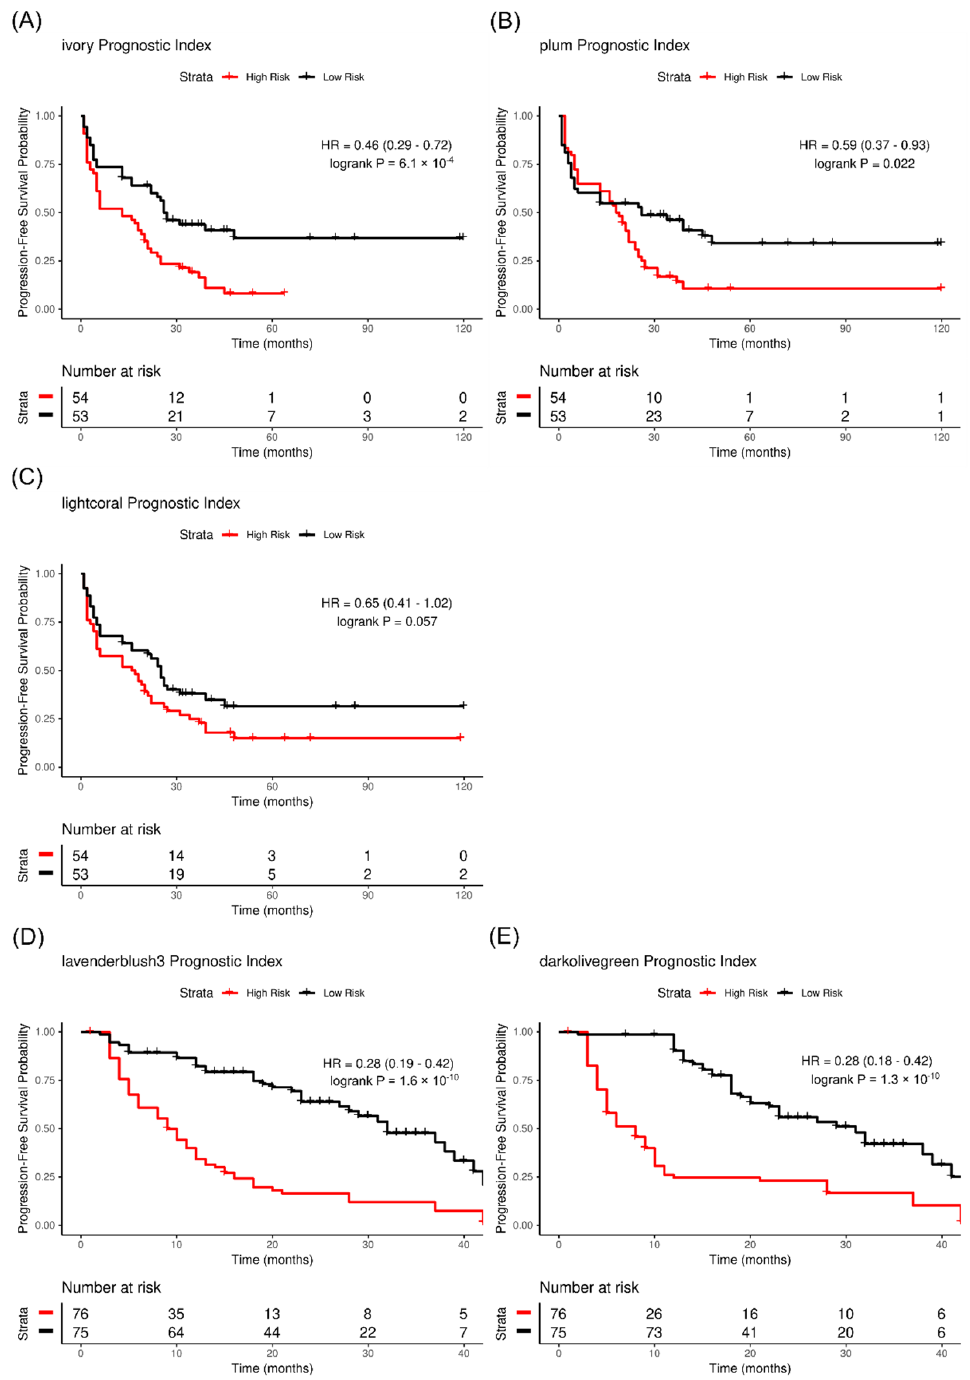
Figure 5. Replication analysis of significant transcript coexpression networks. ( A – C ) Kaplan–Meier analysis of patient PFS association with the prognostic index of miRNA networks ivory , plum , and lightcoral in the MITO cohort. The ivory ( A ) and plum ( B ) miRNA network modules replicated in the MITO cohort ( p = 6.1 × 10 − 4 , log HR = − 0.78 and p = 0.022, log HR = − 0.52, respectively), while the lightcoral module ( C ) reached nominal significance ( p = 0.057, log HR = − 0.43). ( D , E ) Kaplan–Meier analysis of patient PFS association with the prognostic index of mRNA networks lavenderblush3 and darkolivegreen in the AOCS cohort. The lavenderblush3 ( D ) and darkolivegreen ( E ) mRNA network modules replicated in the AOCS cohort ( p = 1.6 × 10 − 10 , log HR = − 1.27 and p = 1.3 × 10 − 10 , log HR = − 1.27, respectively). PFS, progression-free survival; AOCS, Australian Ovarian Cancer Study; MITO, Multicenter Italian Trial in Ovarian cancer.